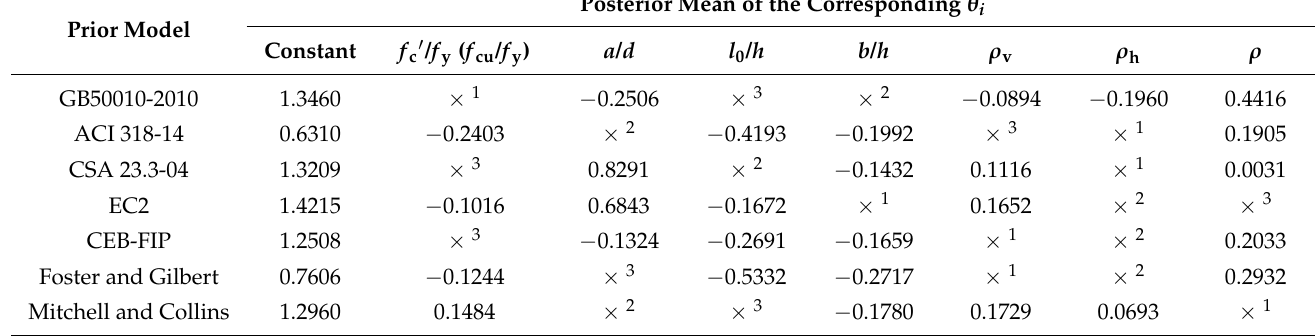
Table 5. Step-wise removal result for other probabilistic models.